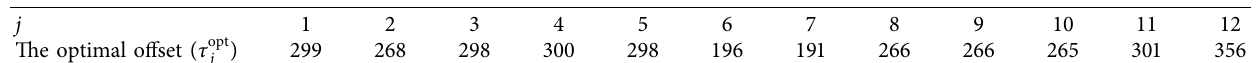
( n 1 ). 1 W fra j of j ( n j + τ j